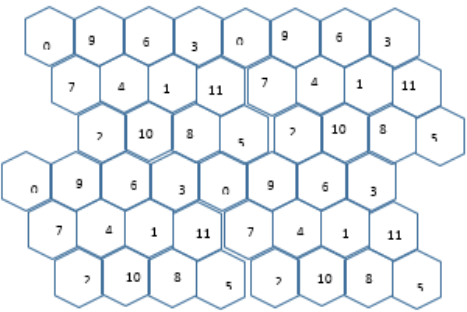
Figure 13. Hypothetical design of a cellular grid labeled with the L(3,1) coloring algorithm.